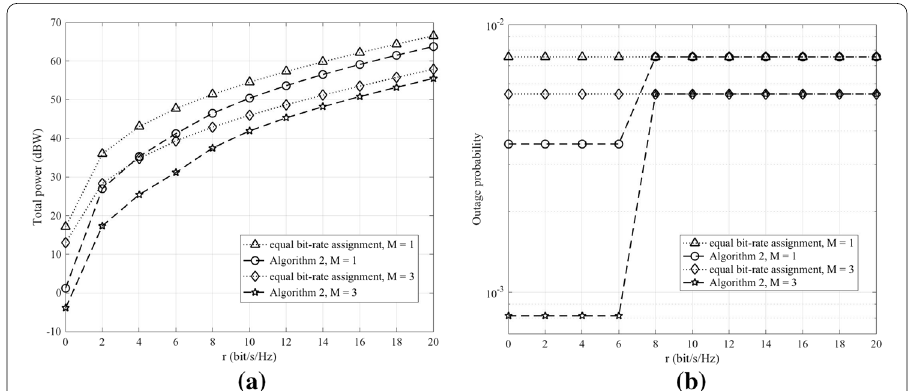
Fig. 4 Total transmit power and outage probability versus r , where d AR = 0.3 , K = 16 and Q out = 0.01 .